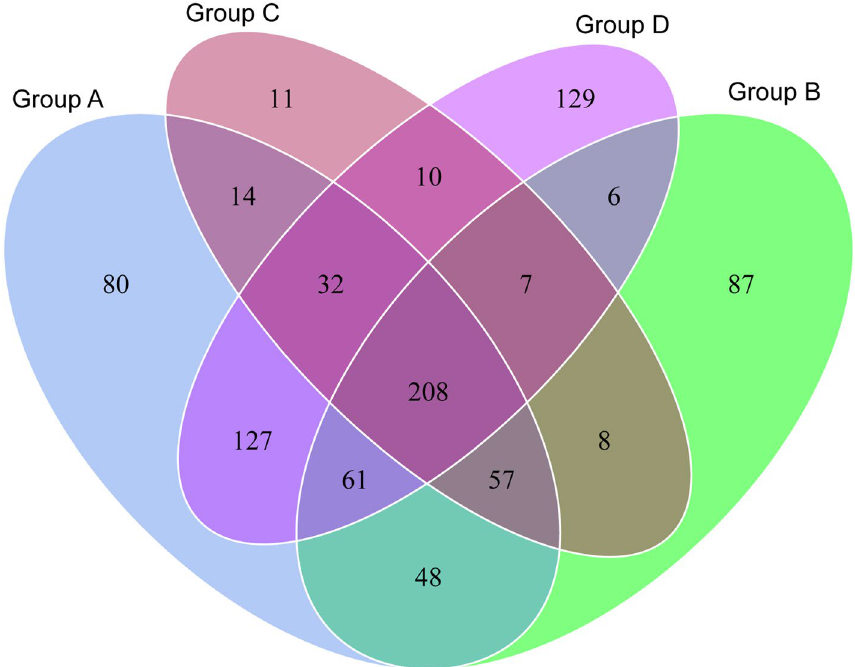
Figure 1. Venn diagram showing the number of OTUs shared between four groups.